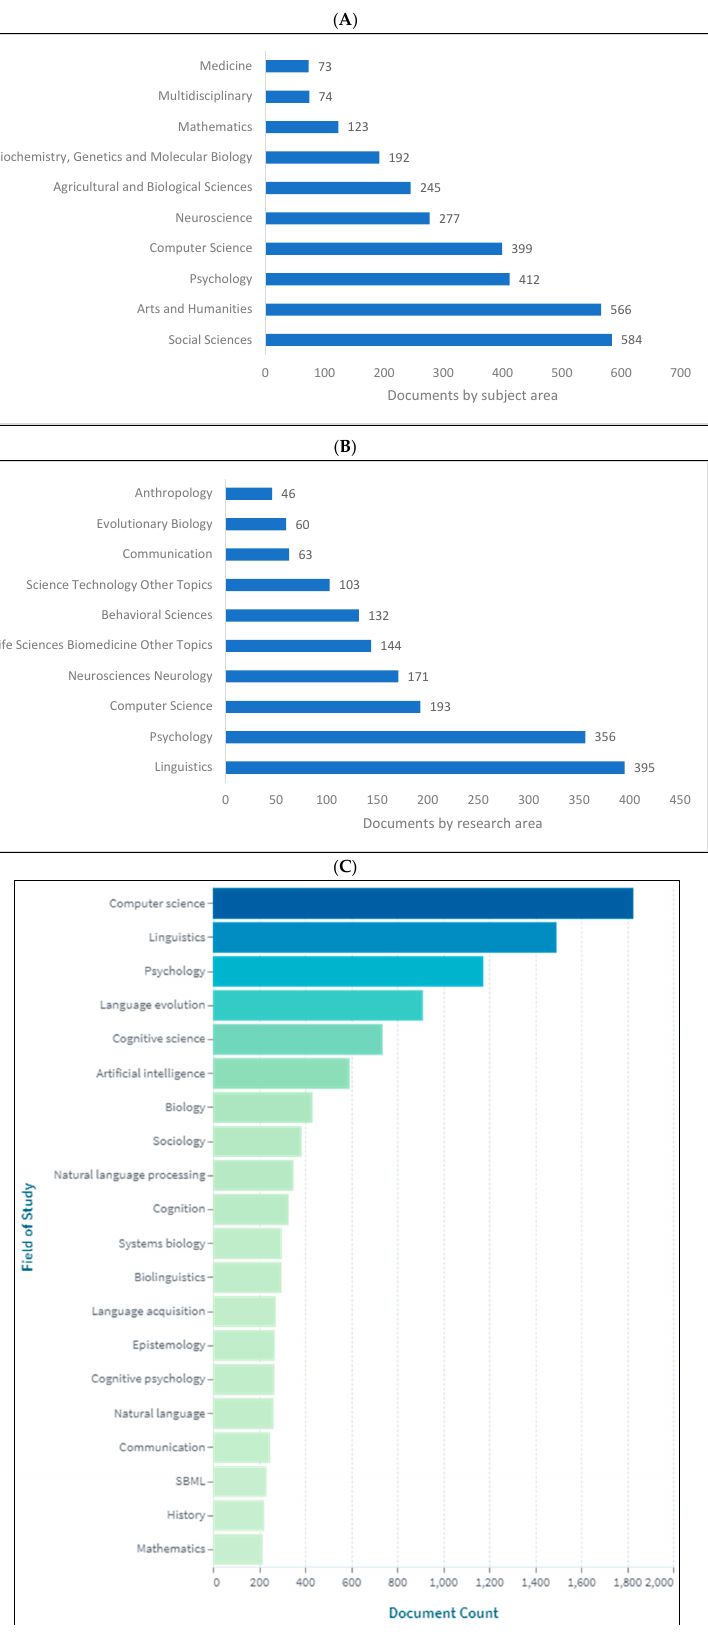
Figure 6. Knowledge production size in biolinguistics by research area. ( A ) (Scopus), ( B ) (WOS), ( C )